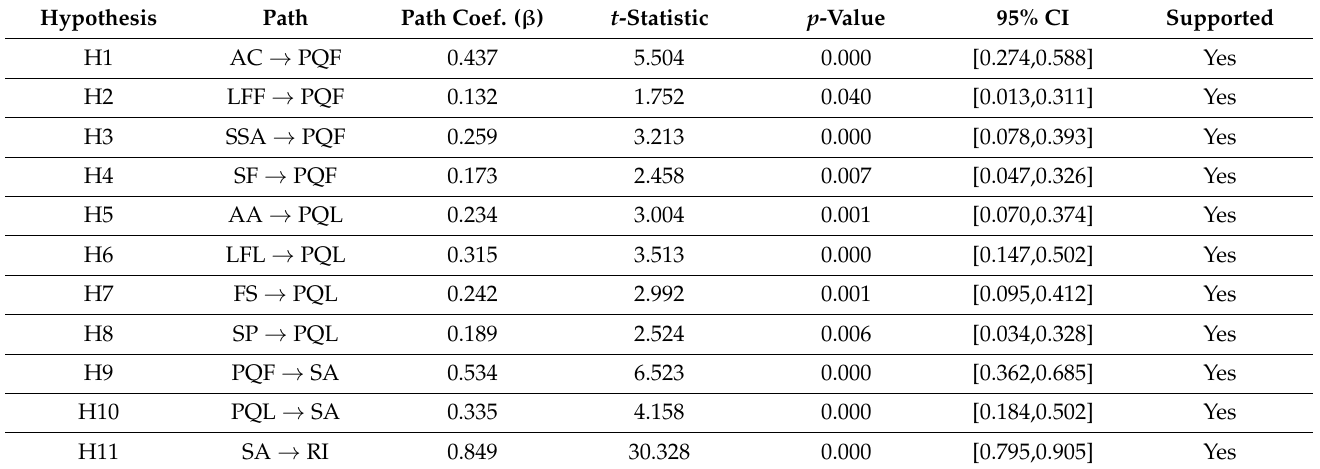
Table 6. Hypothesis Testing Result.